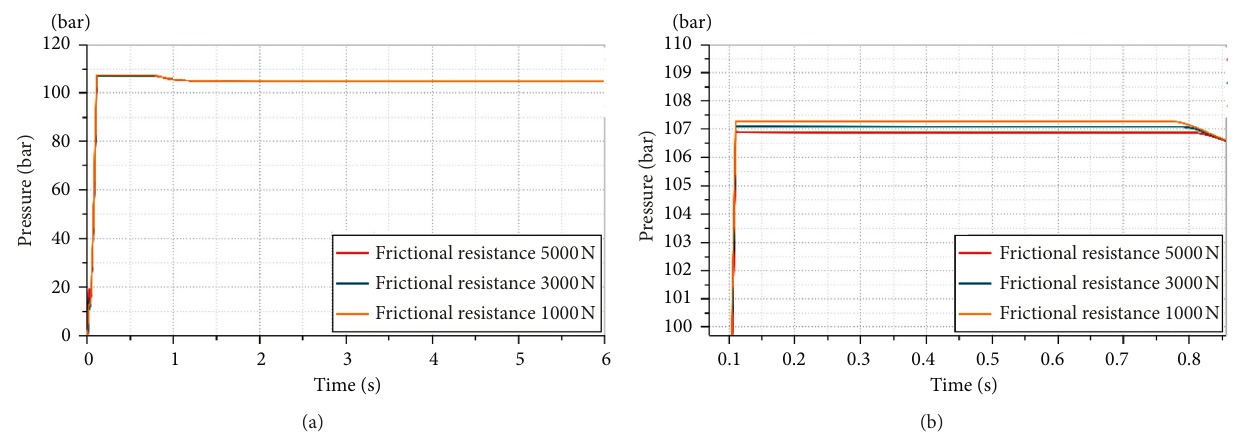
Figure 6: Effect of frictional resistance on the pressure of the rodless cavity.